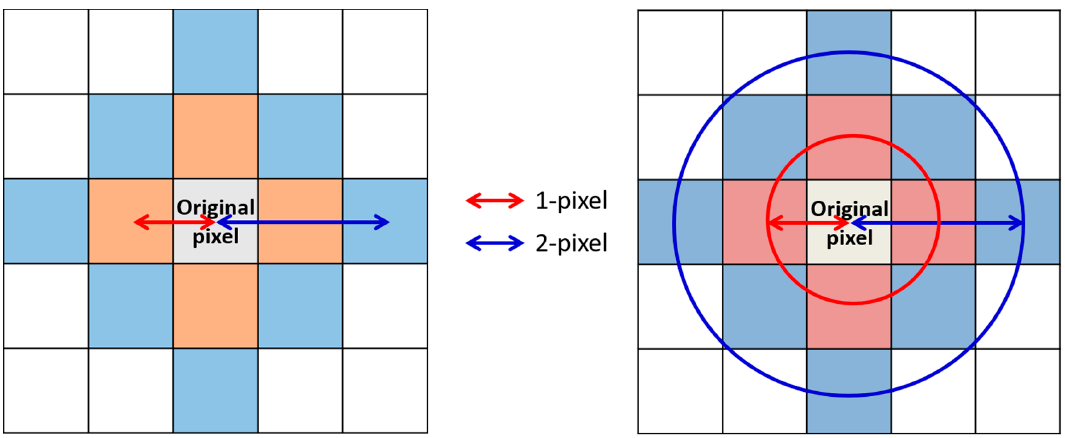
Figure 2. Pixel selection for spatial variability estimation of aerosol optical depth (AOD) from the moderate resolution imaging spectroradiometer (MODIS).